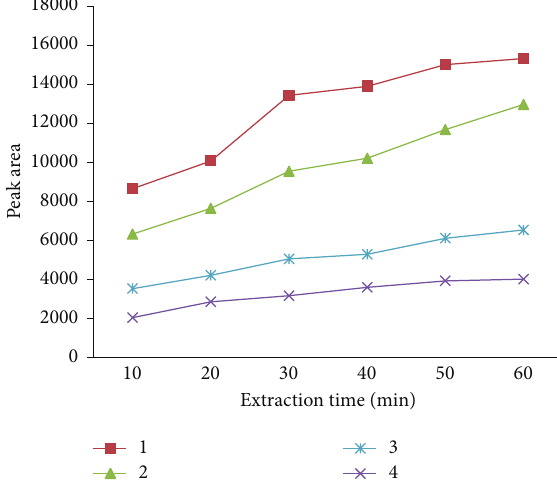
Figure 4: The extraction time profile for 4 representative com- pounds. Conditions: extraction temperature, 70 ∘ C; desorption time, 5 min; saturated out with NaCl; magnetic stirring. Peaks: 1, n C 17 - alkane; 2, pristine; 3, naphthalene; and 4, 5- 𝛼 -Androstane.